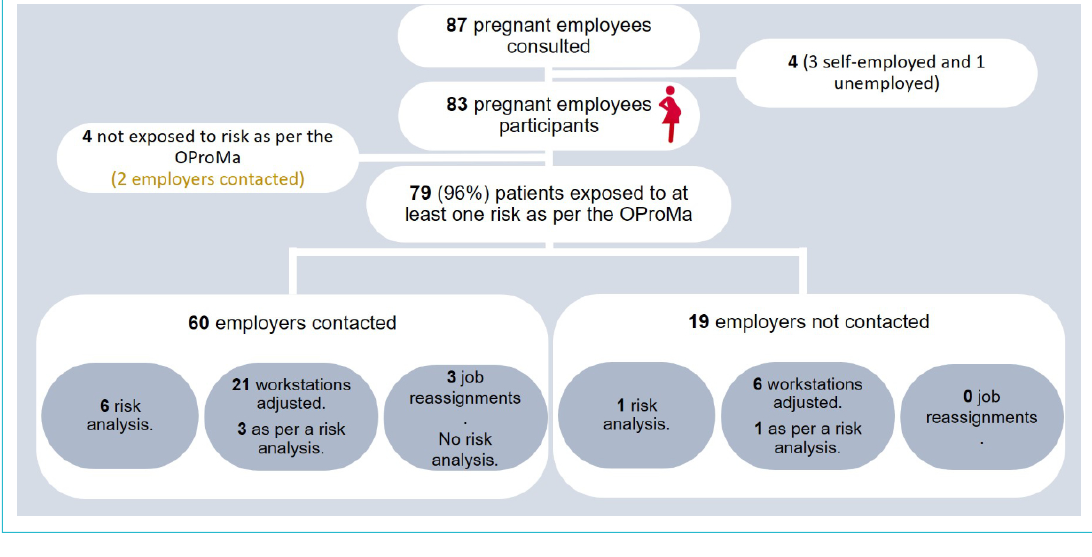
Figure 4: Preventive actions put in place by employers before the occupational medicine consultation.